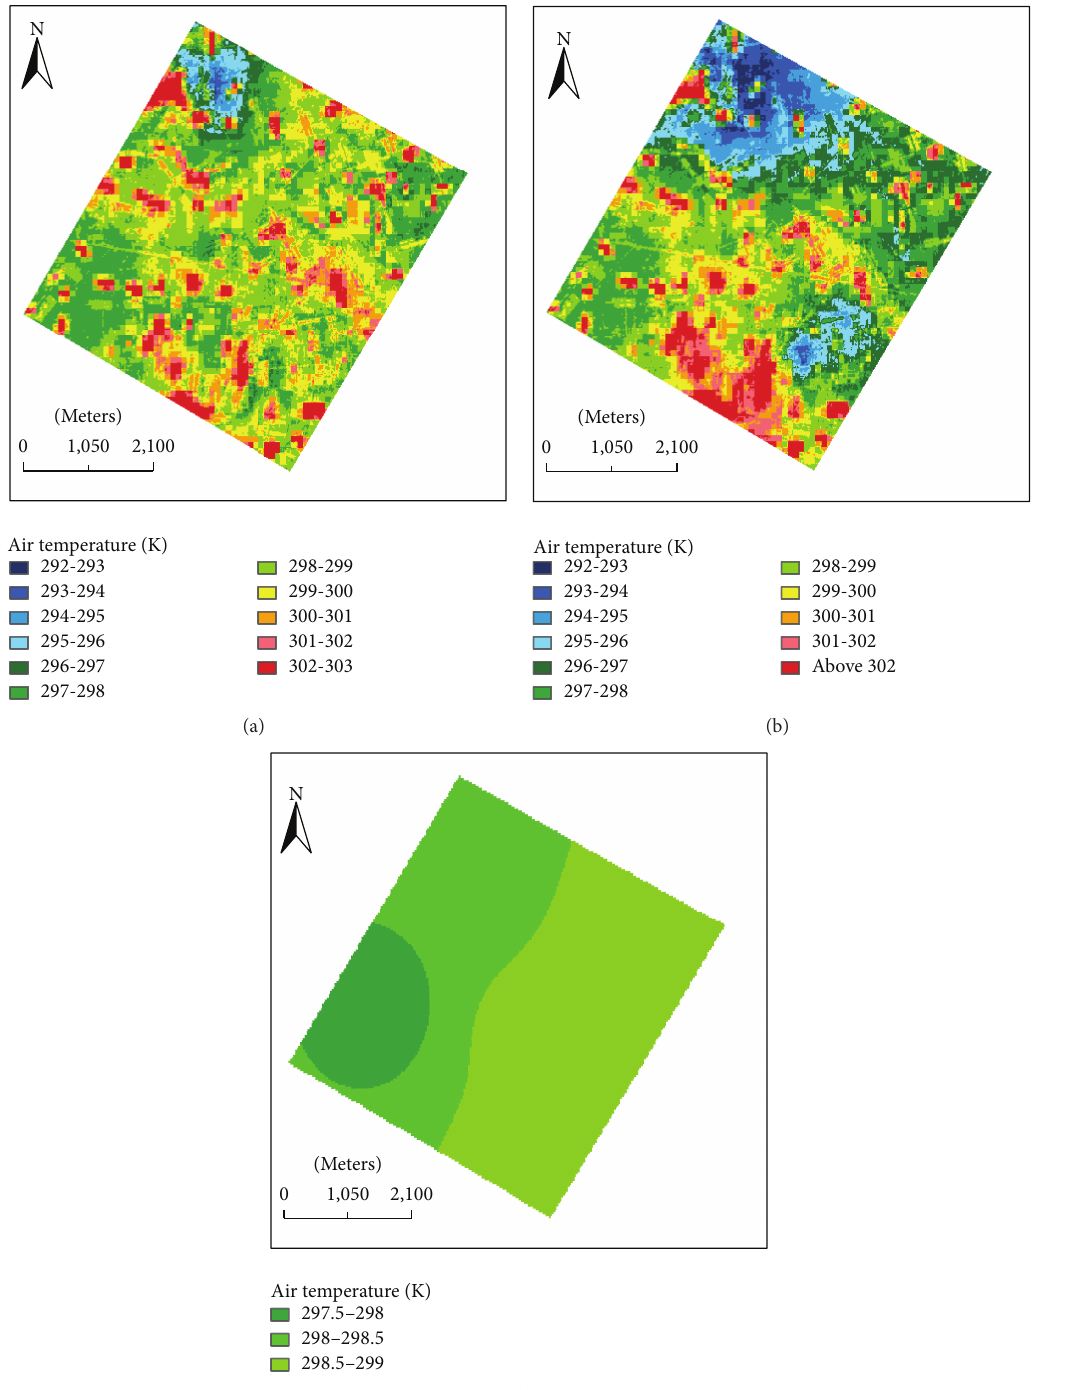
Figure 3: Air temperature retrieved by the IADEBAT model (a), the ADEBAT model (b), and the IDW method (c) on June 24th, 2012.